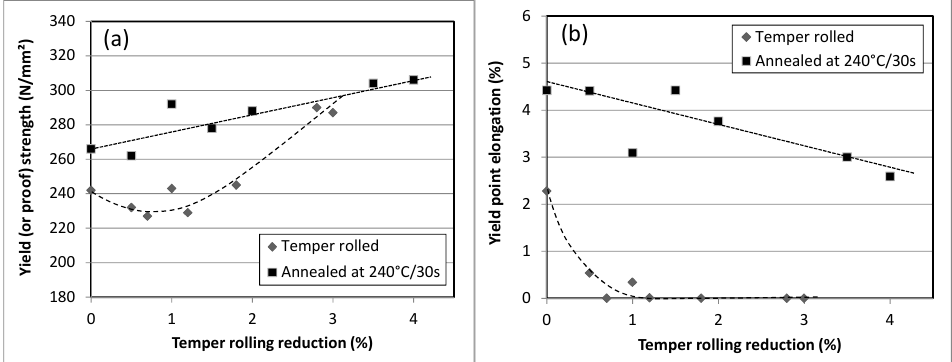
Figure 6. The effect of temper-rolling reduction on ( a ) yield (or proof) stress; ( b ) yield-point elongation.